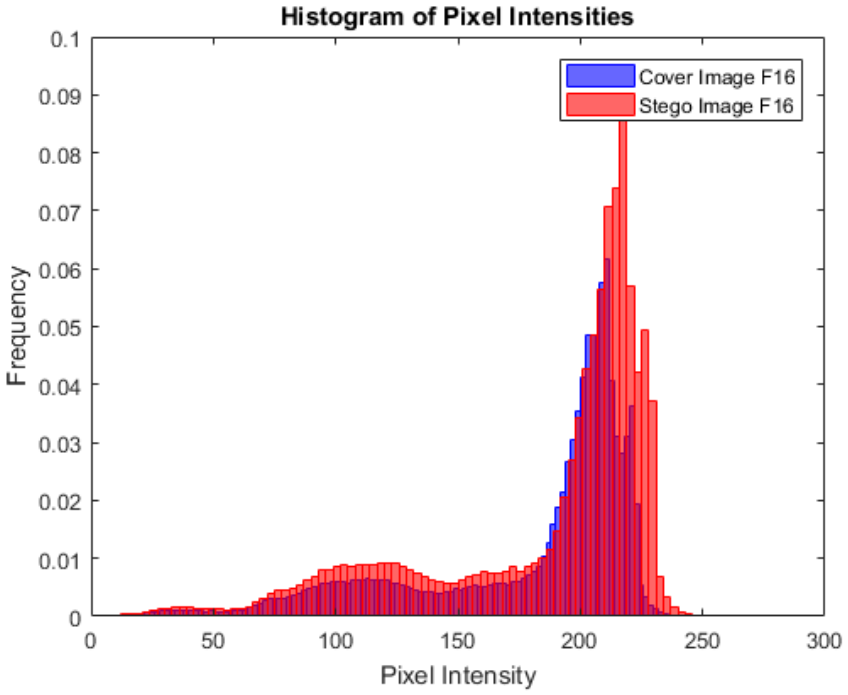
Figure 14. Histogram analysis plots of Wheel for the proposed